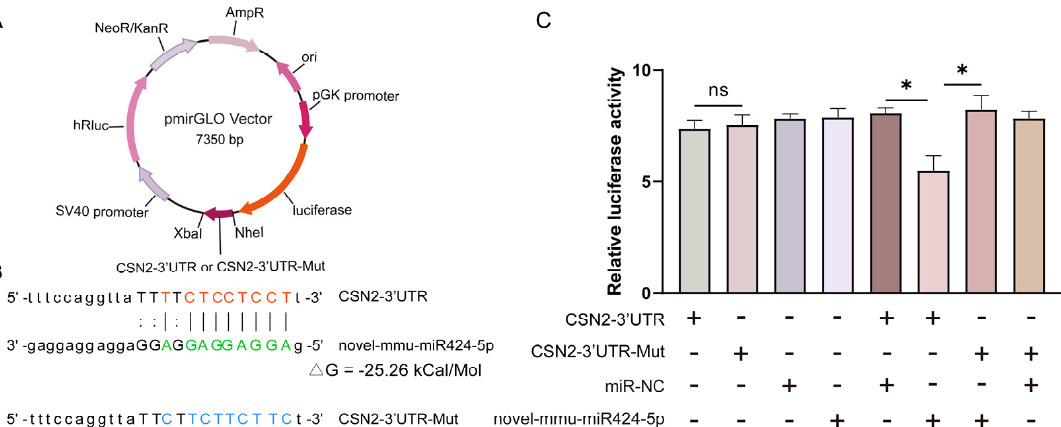
Figure 6. Novel-mmu-miR424-5p targets the 3 ′ UTR of CSN2 : ( A ) A map of pmirGLO vectors car- rying the predicted WT or Mut target sequences of novel-mmu-miR424-5p in the 3 ′ UTR of CSN2 . ( B ) The designed luciferase reporter sequences—WT: the WT CSN2 -3 ′ UTR sequence includes a novel-mmu-miR424-5p binding site; Mut: the sequence of CSN2 -3 ′ UTR with mutation in the novel- mmu-miR424-5p binding site. ( C ) Luciferase activity in 293T cells co-transfected with WT or Mut CSN2 -3 ′ UTR luciferase reporter and novel-mmu-miR424-5p mimics or negative control mimics (miR-NC). +: the vector or mimics was transfected in cells; − : the vector or mimics was not trans- fected in cells. The relative amounts of firefly luminescence normalized to Renilla luminescence are plotted. Data are shown as mean ± SEM values ( n = 3, * p < 0.05, Student’s t -test).